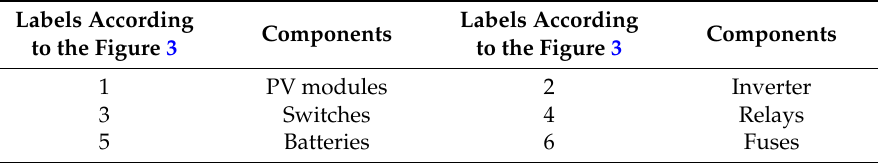
Table 2. The components according to the Figure 3.